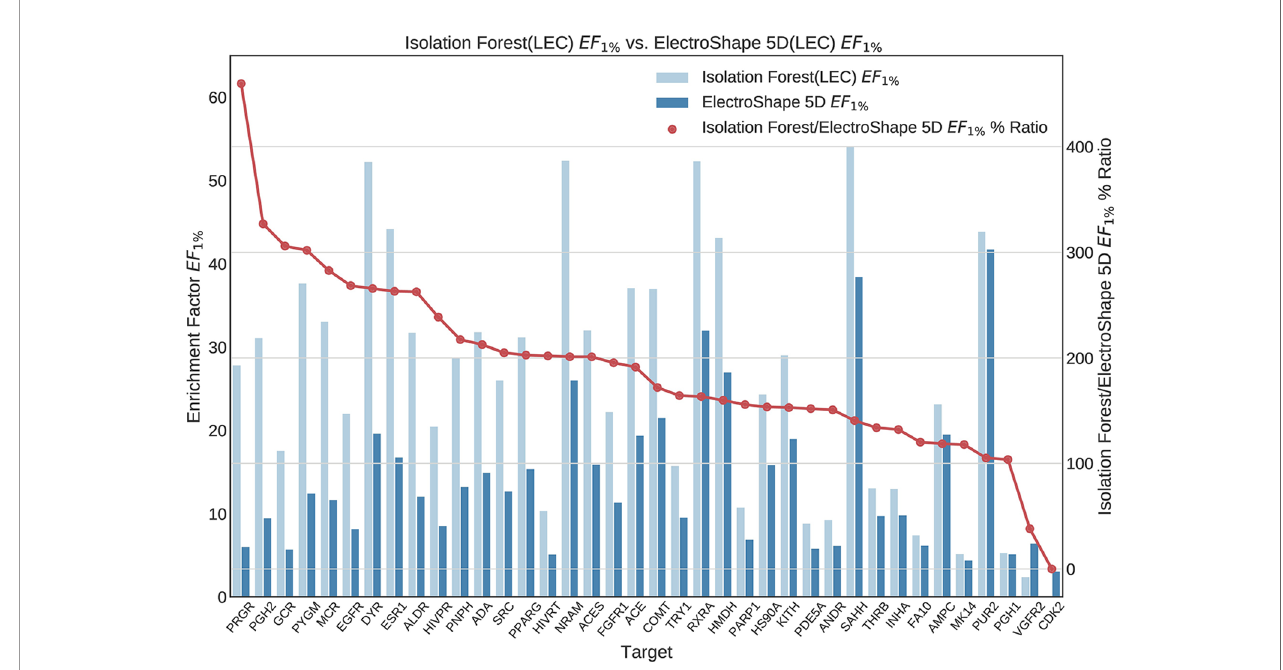
FIGURE 8 | Comparison of Enrichment Factor at 1% obtained by Isolation Forest with that obtained by ElectroShape 5D using Lowest Energy Conformers. Also plotted is the percentage ratio of the Enrichment Factor score of Isolation Forest compared to ElectroShape 5D. Mean ratio = 190% ± 84%, max = 460%, min = 0%.